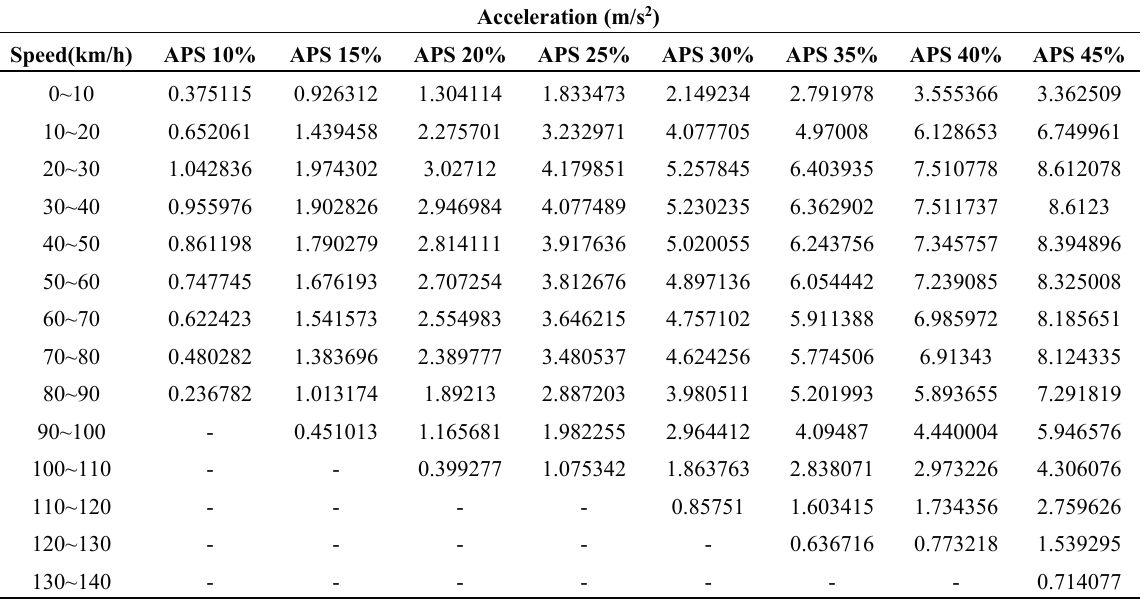
Table 2. Acceleration according to vehicle speed and